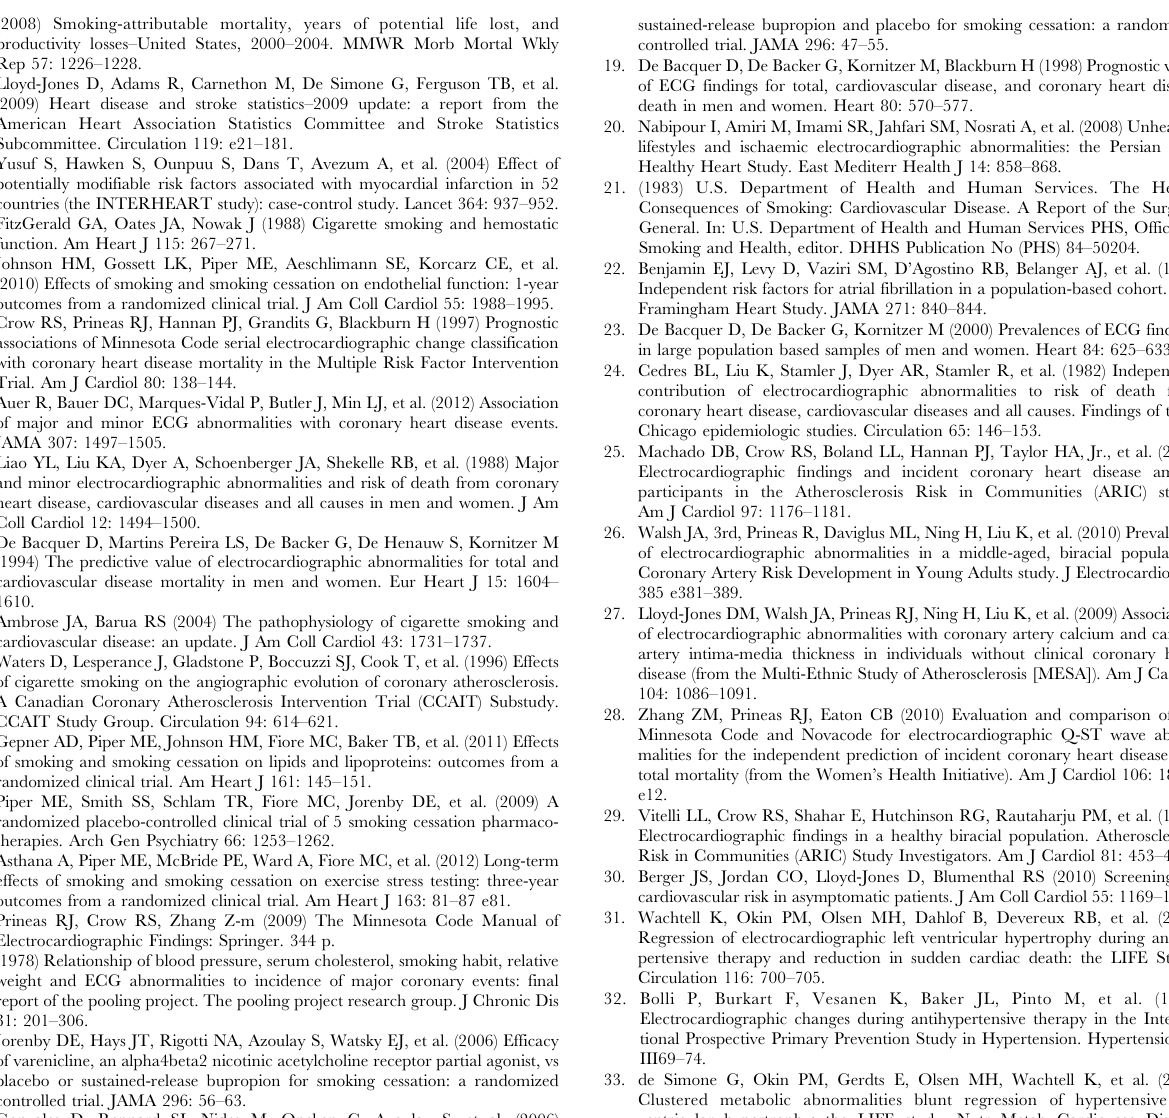
Figure 2. (A). Prevalence of Specific Major ECG Abnormalities. (B). Prevalence of Specific Minor ECG Abnormalities. Figure 2A shows percentages of the specific major ECG abnormalities and figure 2B shows percentages of the specific minor ECG abnormalities at baseline (blue) and at year 3 (red). Year 3 percentages include both continued smokers and those who abstained. All p-values for comparisons between baseline and year 3 ECG abnormalities were non-significant ( , 0.05). BBB=Bundle Branch Block;